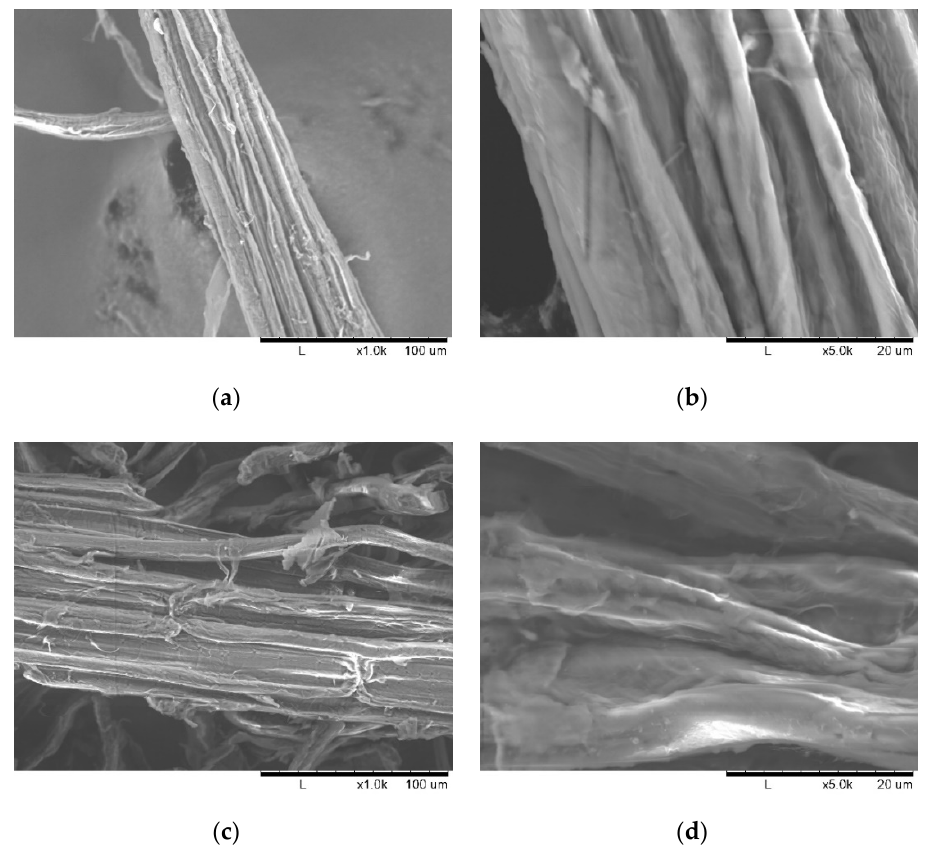
Figure 3. SEM images of M. sacchariflorus G1 pretreated with 0.3 M NaOH at magnification: ( a ) ×1000 and ( b ) ×5000 without ultrasonication treatment; and at magnification: ( c ) ×1000 and ( d ) ×5000 with 1 h ultrasonication treatment.